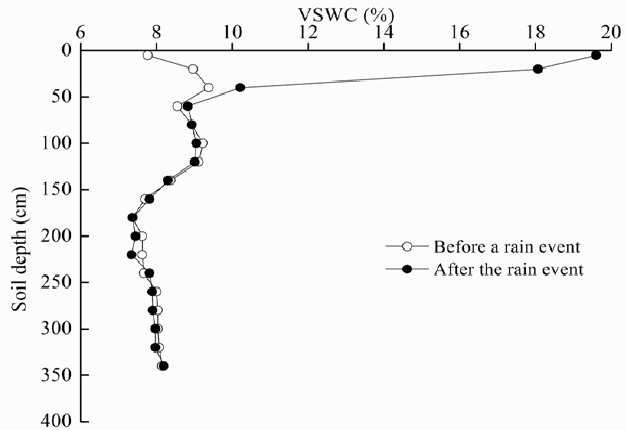
Figure 3. The vertical changes in soil moisture with increasing soil depth after and before a rainfall event in caragana korshinskii shrubland.